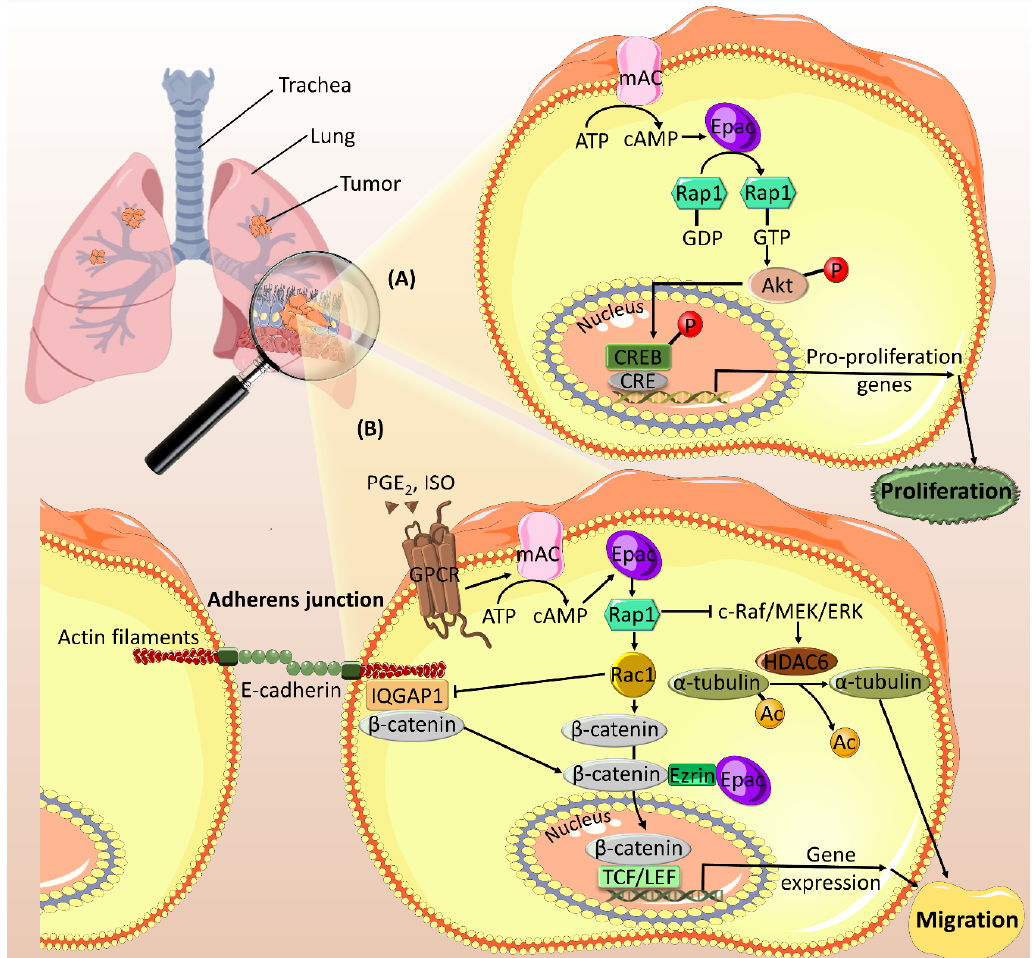
Figure 3. Epac promotes cell proliferation ( A ) and migration ( B ) in lung cancer. ( A ) Epac activates its downstream effector, Rap1, which increases the phosphorylation of Akt. Activated Akt mediates the phosphorylation of CREB in the nucleus. Upon its phosphorylation, CREB binds to CRE site on the DNA promoting the transcription of genes involved in cell proliferation. ( B ) Epac mediates PGE2- and ISO-induced cell migration by regulating different downstream effectors. PGE2 mediates cAMP-